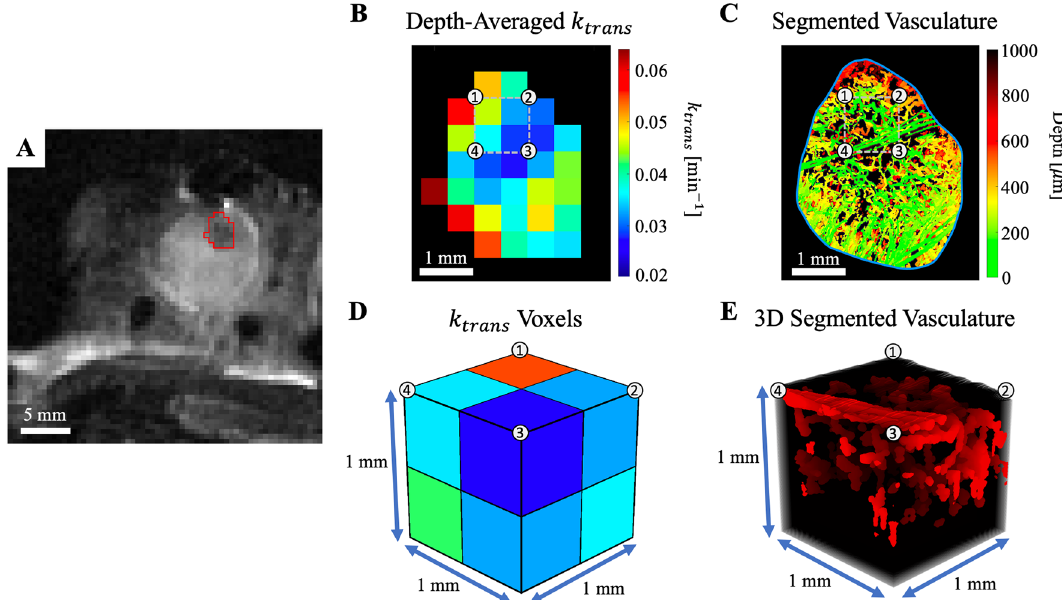
Figure 3. Co-registered macro DCE-MRI to micro svOCT vascular correlations. ( A) T 2 -weighted structural MRI scan of the window chamber with tumor delineated by the red contour. ( B) k trans parameter map of the tumor, averaged over two depth slices (total depth of 1 mm to correspond with svOCT’s imaging penetration), in units of min −1 indicated by the colour bar. ( C) svOCT segmented depth-encoded vasculature coregistered to ( B) . The grey dotted line in ( B) and ( C) shows one position of the 1mm 3 sliding window VOI with numbered edges that correspond to the number locations in ( D) and ( E) . The various semi-quantitative and quantitative MR vascular metrics in the resulting DCE-MRI voxels (8 k trans voxels in this example) ( D ) are directly compared to microvascular biomarkers derived from the corresponding svOCT 3D microvascular map ( E ). The VOI then slides throughout the delineated tumor contour, with such analysis repeated at all positions. ( B) –( E )